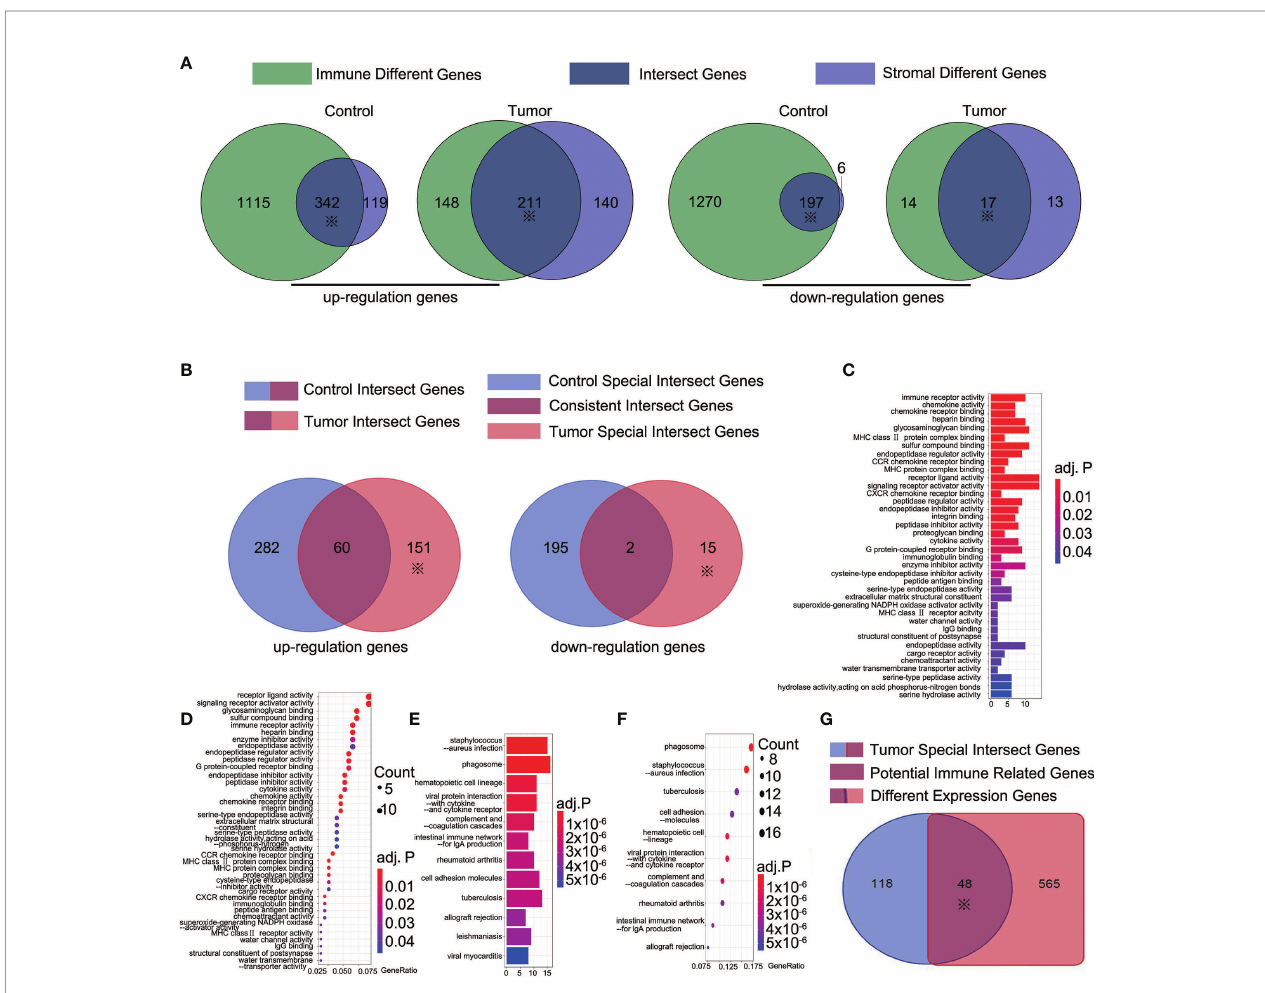
FIGURE 2 | 166 tumor-special intersect genes were identi fi ed and 48 of them identi fi ed as potential immune-related genes. (A) 461 (203) and 351 (30) up-regulated (down-regulated) genes were identi fi ed using ESTIMATE in the control and tumor samples. ※ mean this part would be used in following step; (B) 151 up-regulated and 15 down-regulated ESTIMATE score genes (total 166 tumor-special intersect genes) were speci fi cally expressed in the tumor samples; (C) The Go analyses of 151 up-regulated tumor-special intersect genes; (D) The KEGG analyses of 151 up-regulated tumor-special intersect genes; (E) . The Go analyses of 15 down- regulated tumor-special intersect genes; (F) The KEGG analyses of 15 down-regulated tumor-special intersect genes; (G) 48 intersected genes, referred to potential immune-related genes, were identi fi ed between 613 DEGs and 166 tumor-special intersect